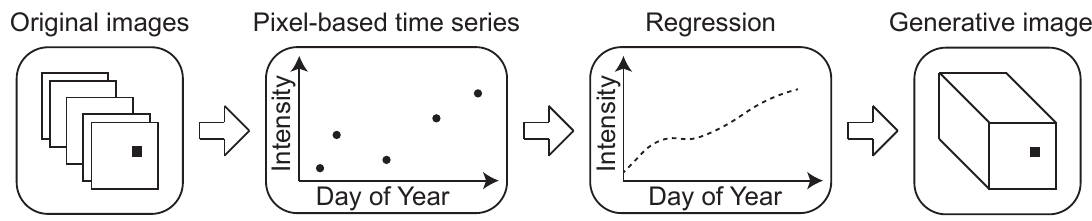
Figure 10. Graphical overview of Gaussian process-based temporal